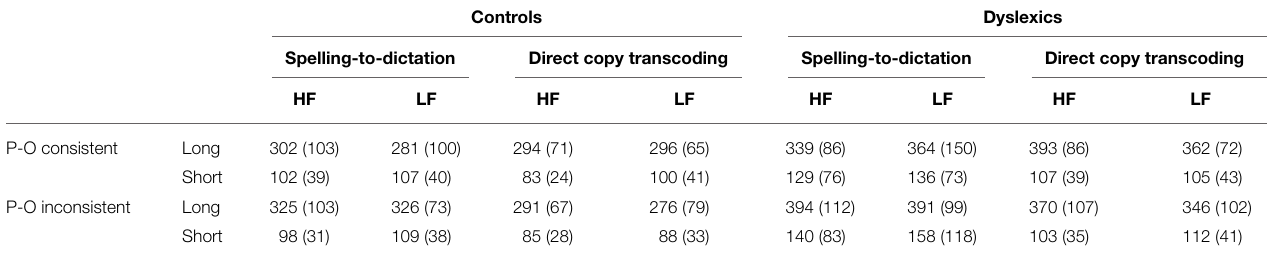
TABLE 3 | Mean ILI durations (in milliseconds) and standard deviations (in parentheses) for each condition in the control and the dyslexic group. Controls